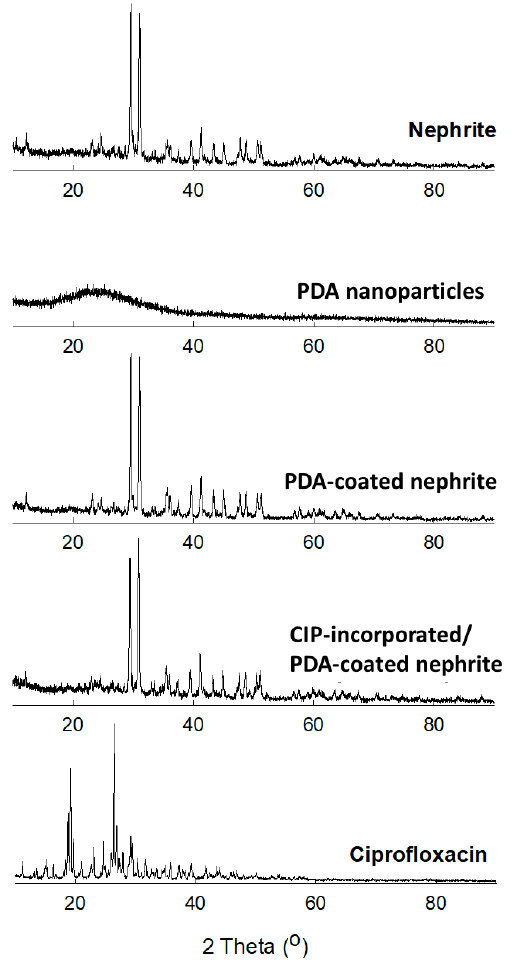
Figure 4. Powder XRD diffractograms of nephrite, PDA nanoparticles, PDA-coated nephrite com- posites (Dopamine/nephrite ratio = 1.0/1.0), CIP-incorporated/PDA-coated nephrite composites (CIP/dopamine/nephrite ratio = 0.2/1.0/1.0) and ciprofloxacin HCl (Ciprofloxacin).